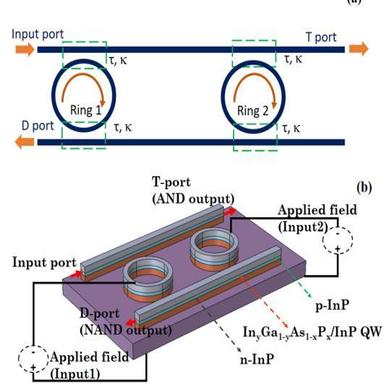
(a) Parallel DRR for realizing AND NAND gate. (b) Perspective view of AND NAND gate based on EA QW embedded on parallel MRR.